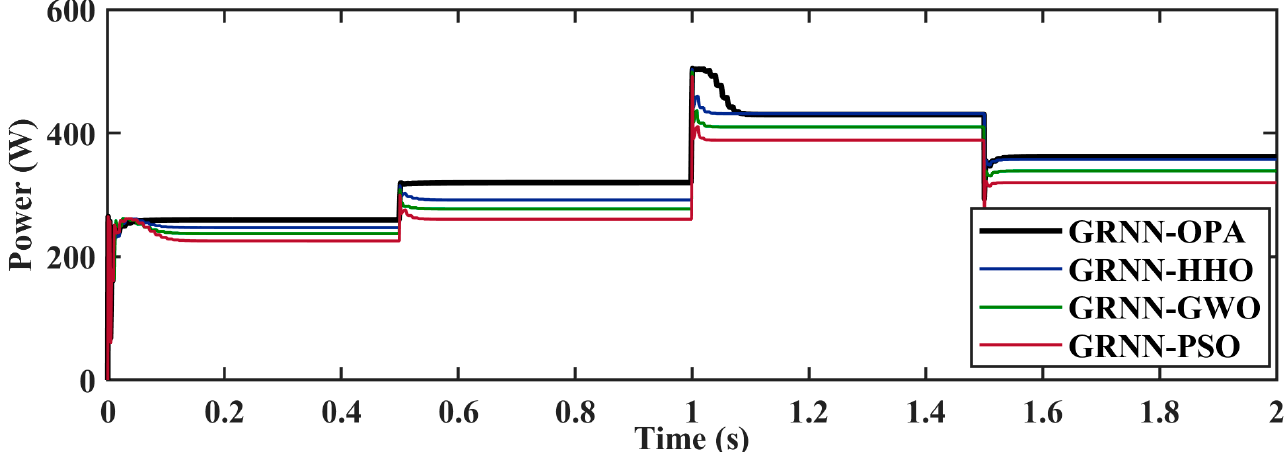
Figure 10. Comparison of power tracked in case 2.